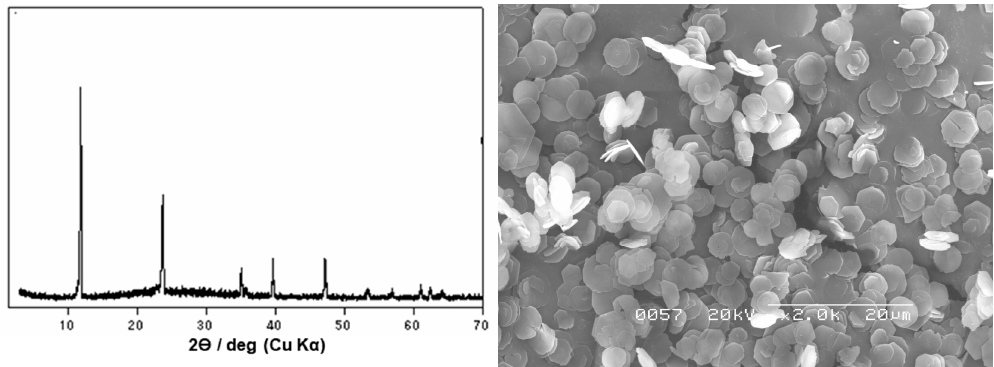
Figure 7. XRD pattern and SEM image of MgAl-LDH prepared by the homogeneous precipitation method using urea. Reproduced with permission from reference [81].